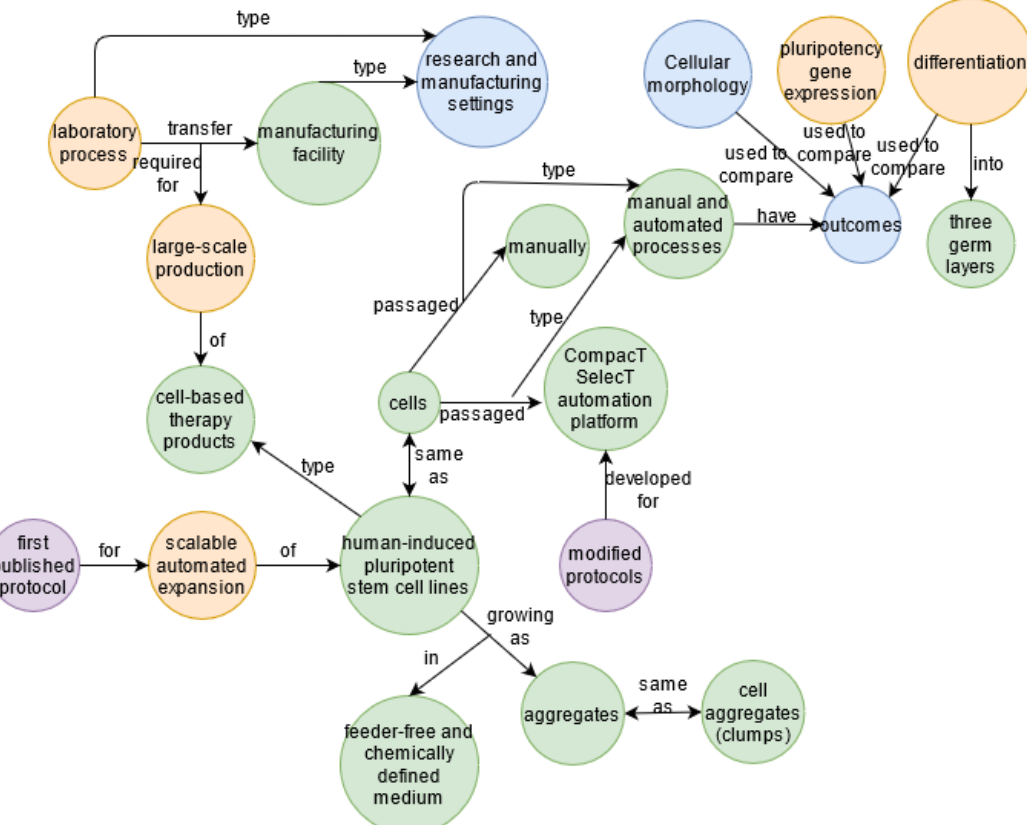
Figure A1. Structured KG representation of a Biology domain publication Abstract [65] as process, method, material, and data entities.